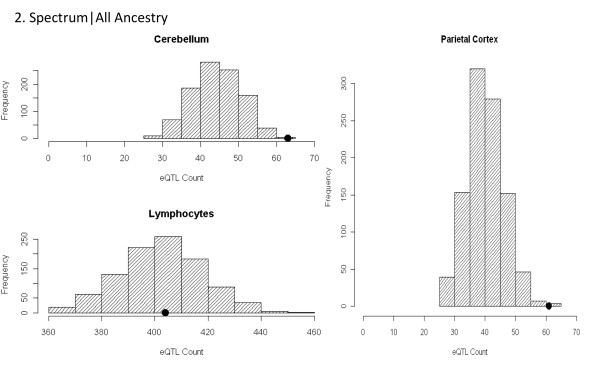
 Histograms of expression quantitative trait loci enrichment analyses for Spect|All analyses. The gray histogram distributions represent the null distribution created by 1,000 lists of randomly ascertained SNPs drawn from the 1 M array platform and conditioned on minor allele frequency. The black dot represents the actual count of SNPs annotated as eQTL present in each tissue in the Spectrum|All Ancestry analysis. We observed significant enrichment of parietal (P <0.004) and cerebellar (P <0.003) eQTL, but not LCL eQTL (P <0.502). eQTL: expression quantitative trait loci; LCL: lymphoblastoid cell line; SNP: single nucleotide polymorphism.